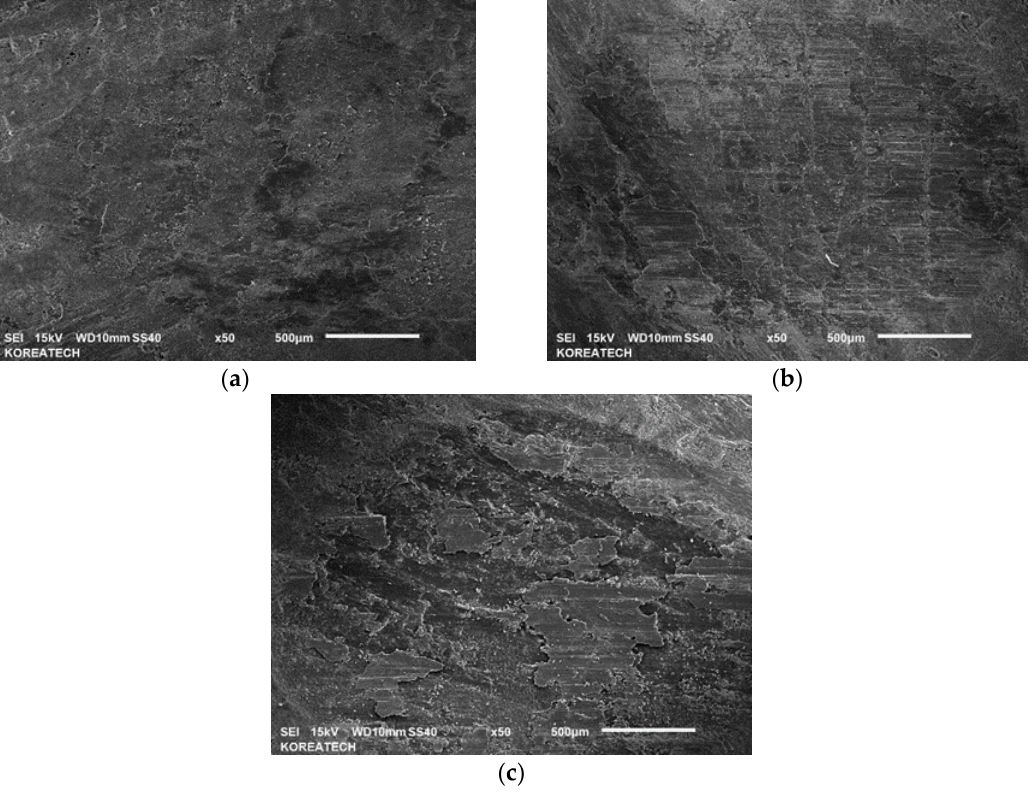
Figure 6. SEM images of wear track formed on the C/C-SiC composite at temperatures of 25 °C ( a ); 100 °C ( b ) and 200 °C ( c ).